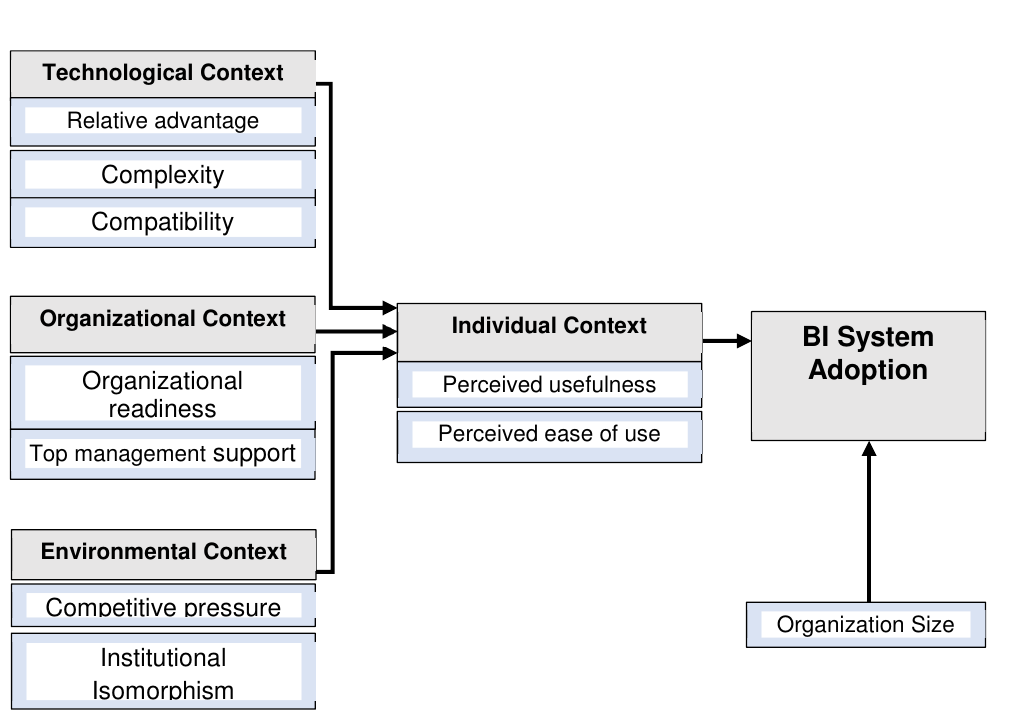
Fig. 4: Conceptual model of BI system adoption for the Textile and Apparel